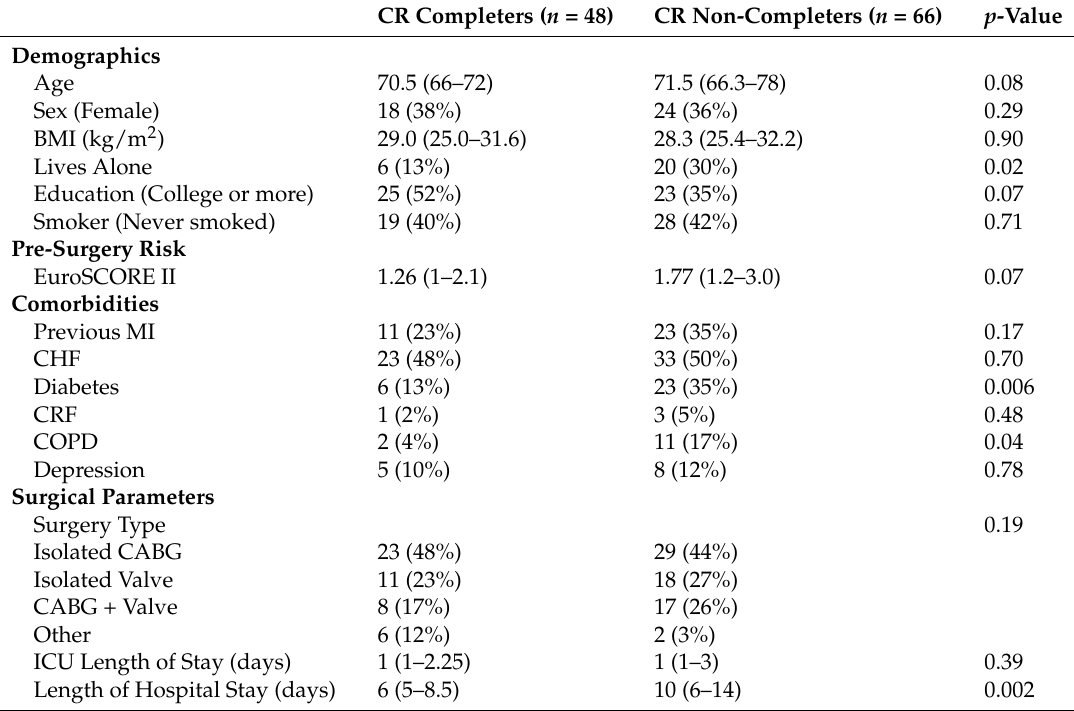
Figure 1. Participant flow diagram. Table 2. Characteristics comparing CR completers to non-completers.